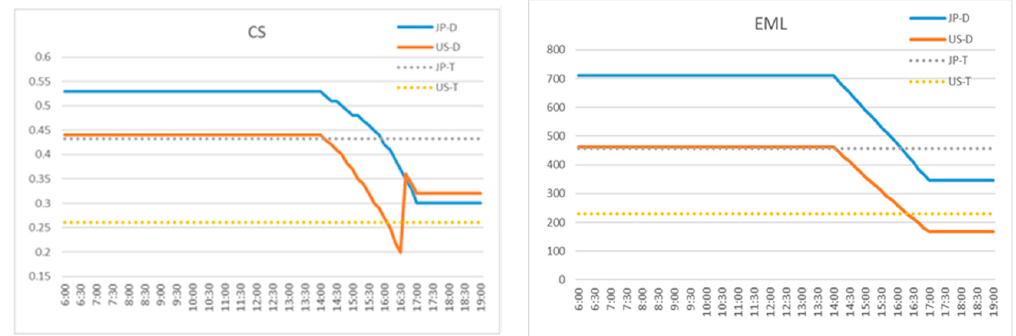
Figure 11. Non-visual impact estimation using CL and EML approaches.